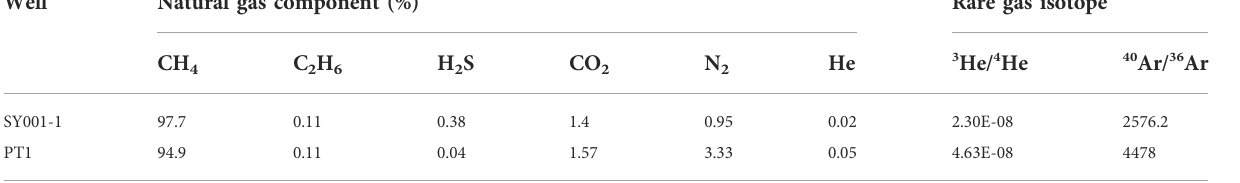
TABLE 1 Gas composition and isotope data from the Qixia Formation in the Shuangyushi structure. Well